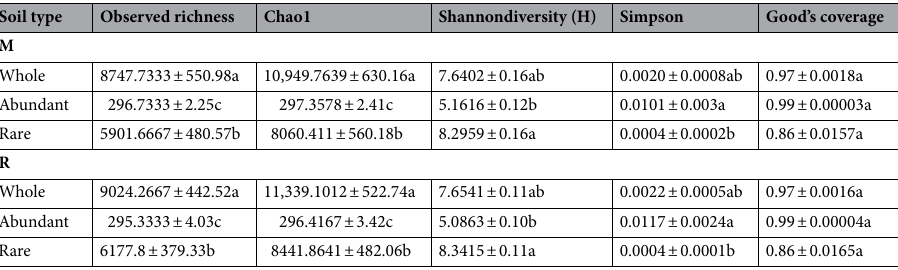
Table 2. The soil microbial diversity and abundance in different cropping patterns of tobacco. Different letters within the same column indicate significant differences at ( p < 0.05). M tobacco monoculture, R tobacco-rice rotation, Whole whole bacterial communities, Abundant abundant taxa, Rare rare taxa.